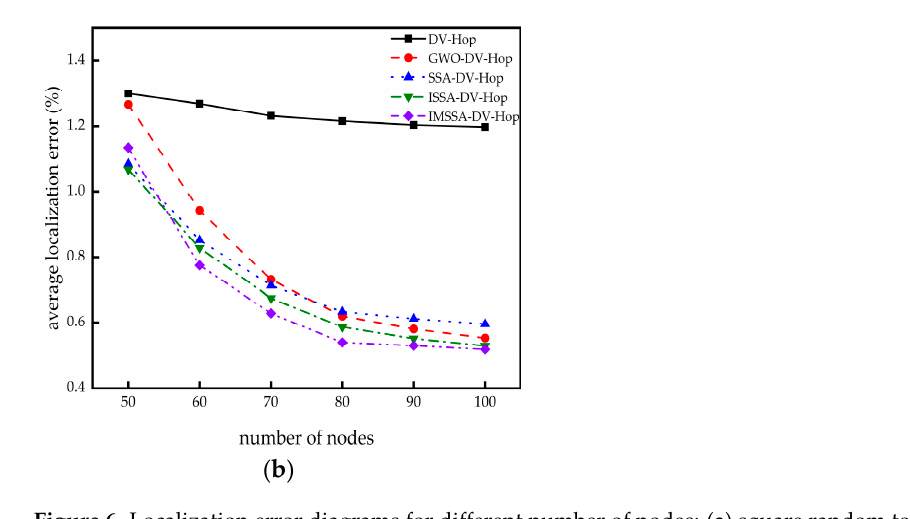
Figure 6. Localization error diagrams for different number of nodes: ( a ) square random topology; ( b ) C-shaped random topology. Table 4. Localization error in different number of nodes in square random topology.